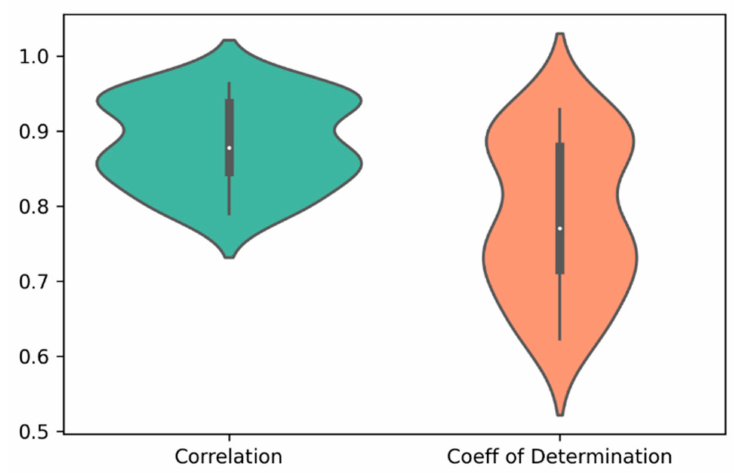
Figure 2. The distribution of correlation (R) and coefficient of determination (R 2 ) of the predicted and observed log(IC50) values in the 30 paired clusters of cell lines and drugs. The average values of R and R 2 were 0.88 and 0.78, respectively.